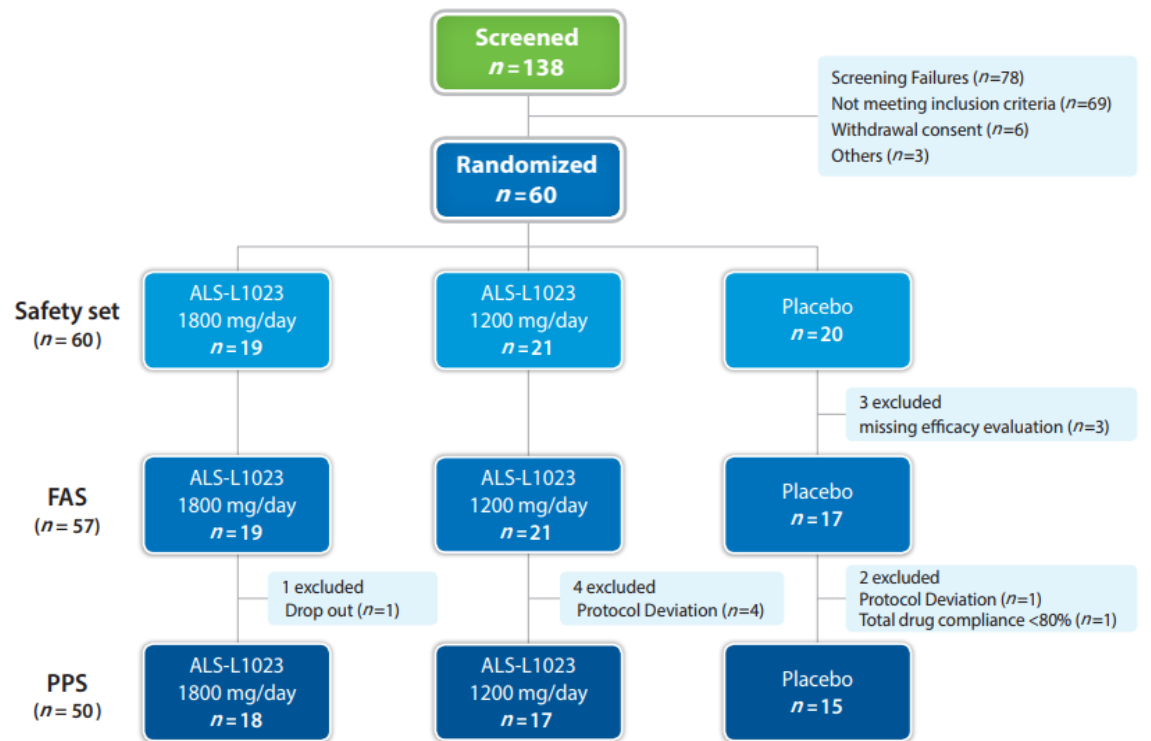
Figure 1. Clinical study flow diagram.